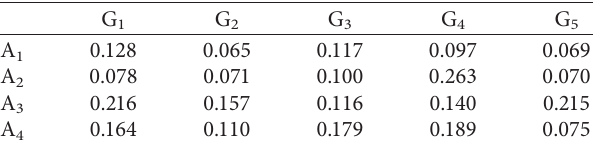
Table 4: Initial differences for each